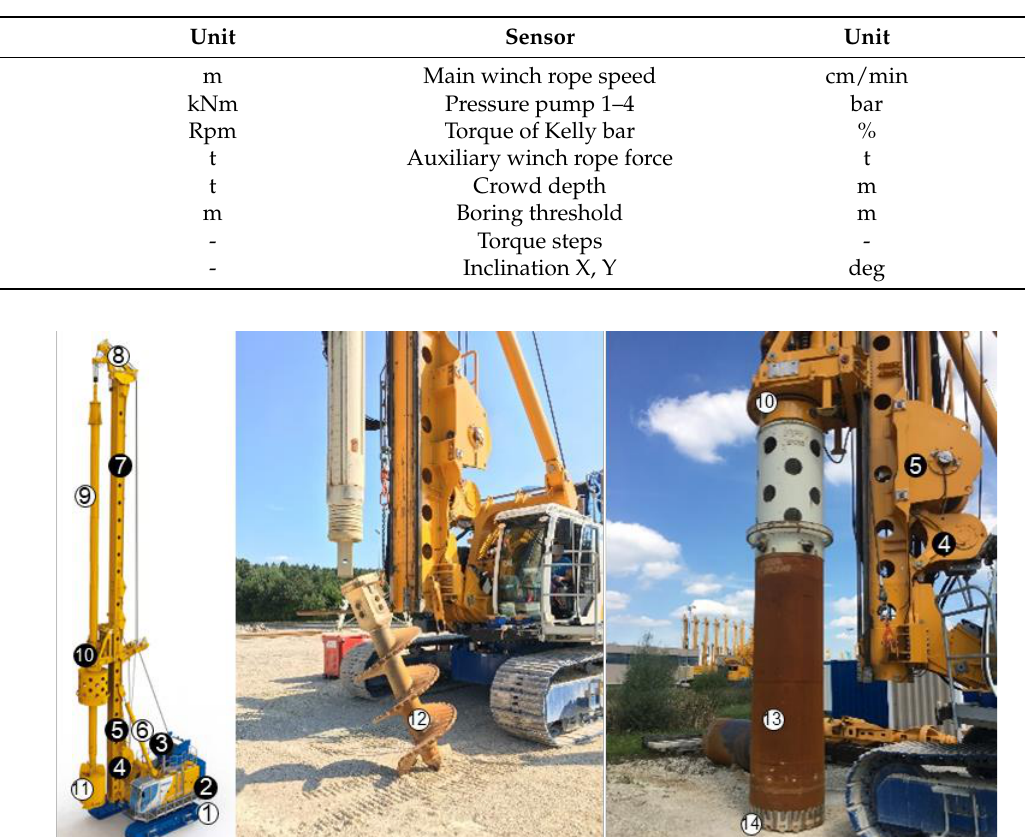
Table 1. Sensor data available from the Kelly drill rig.